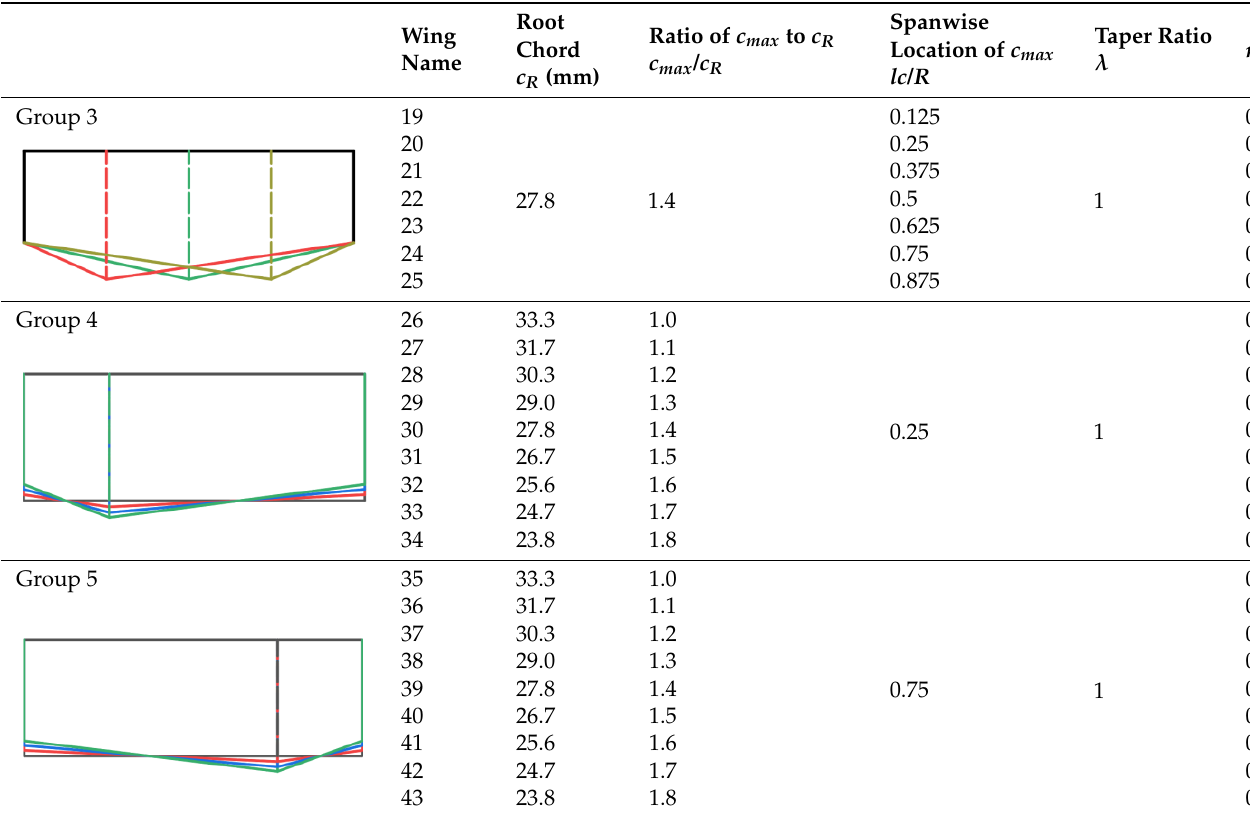
Table 2. List of wings with different r 2 by changing maximum chord length c max and its spanwise location.